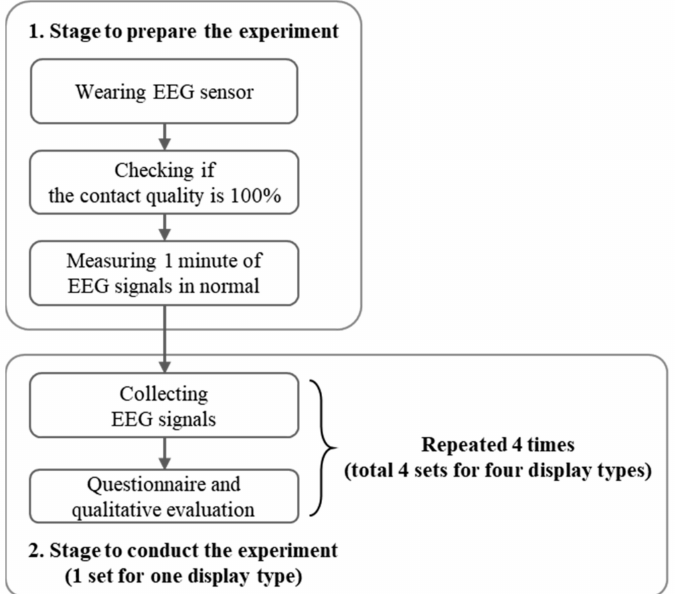
Figure 3. Experimental